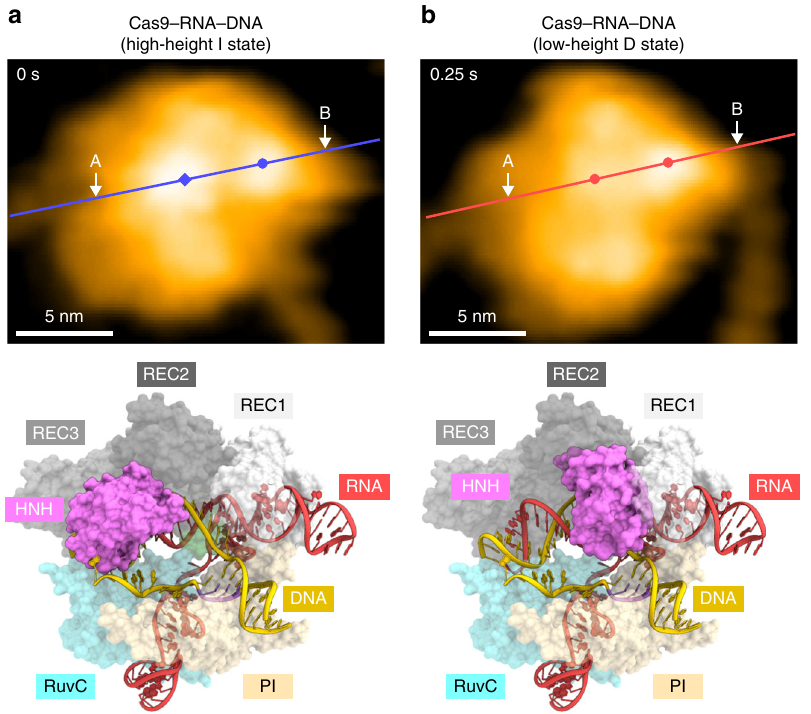
Fig. 4 Structural rearrangement of the HNH domain. a , b HS-AFM images of the HNH domain in the high-height ( a ) and low-height ( b ) states. The mean center positions of the HNH and REC1 domains are indicated by dots. Red and blue lines indicate the cross-sectional position used for the height distribution analysis in Supplementary Fig. 5d. For comparison, the Cas9 – RNA – DNA models in the I and D states are shown below the respective images. The structural models consist of Cas9 – RNA (PDB: 4OO8) and DNA (PDB: 5F9R), and the D state model was built as described previously 17 . The scale bars are 5